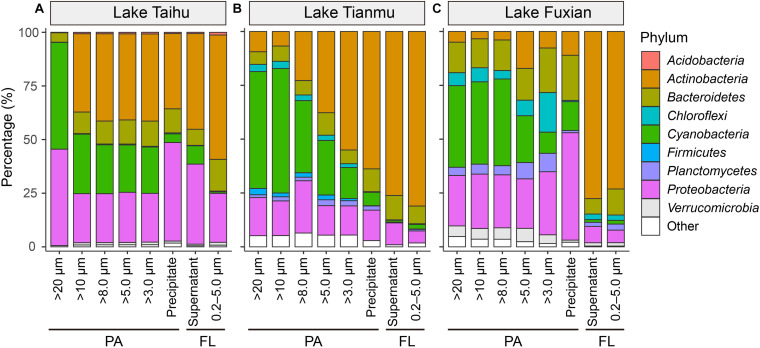
Mean percentage (%) of major bacterial taxa in each treatment at phylum level in (A) Lake Taihu, (B) Lake Tianmu, and (C) Lake Fuxian. The nine most abundant bacterial phyla are shown individually, and minor taxa are combined as “other”. PA, particle-attached; FL, free-living.